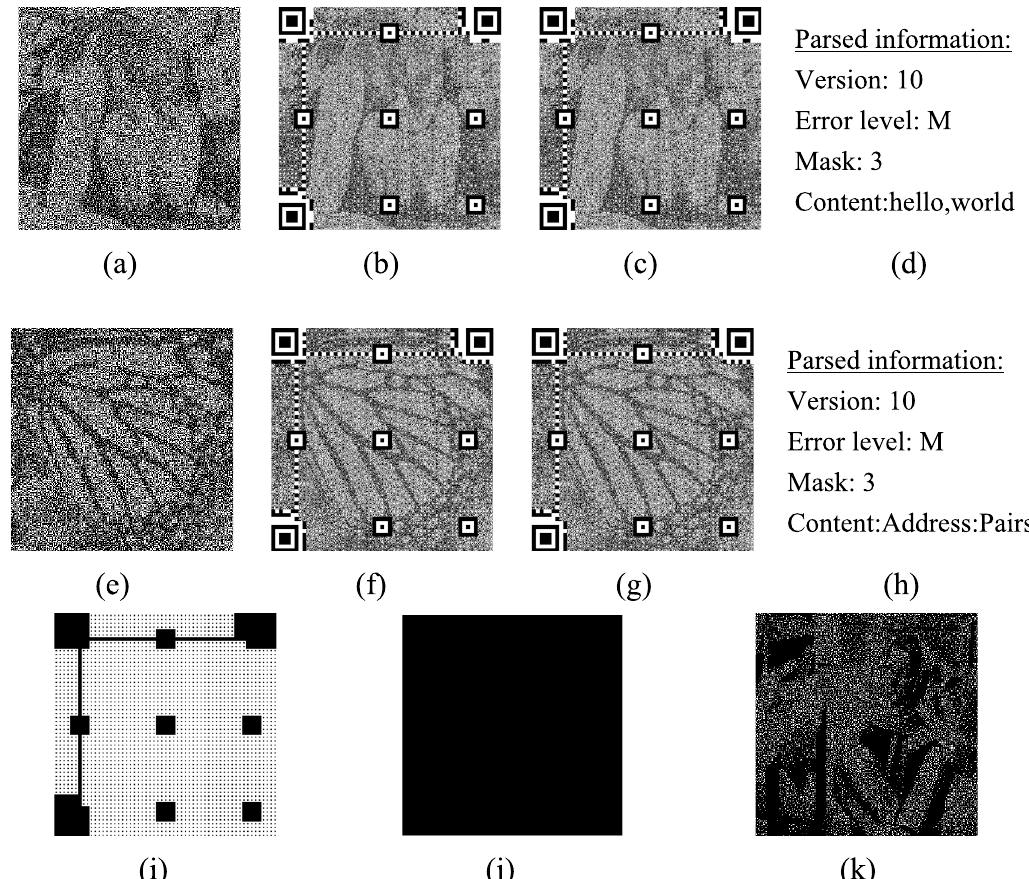
Figure 3. The experimental results of encryption, embedding, and recovery images. Halftoned cover images ( a , e ); cover images mixed with QR codes ( b , f ). Cover images embedded with overlayed pixels ( c , g ); parsed information with the zxing 16 tool ( d , h ); mask image for QR codes ( i ); ( j ) is the difference between ( f , g ); recovery image ( k